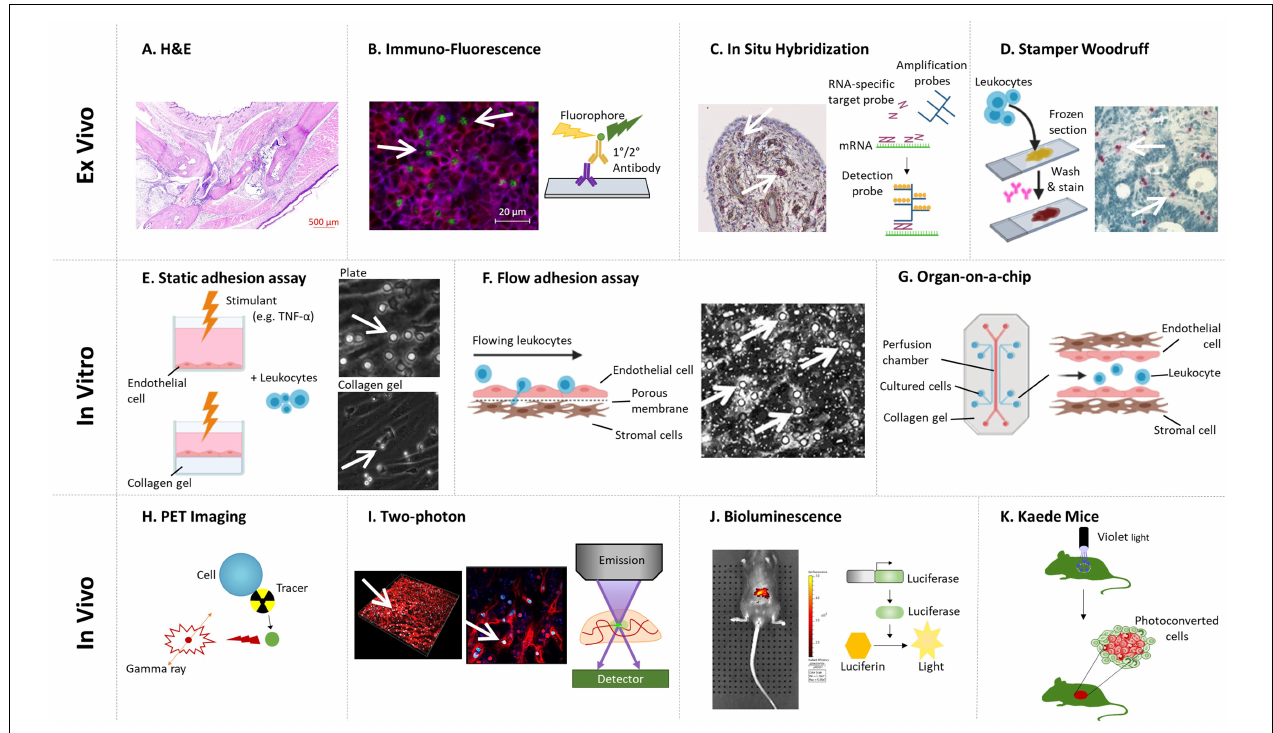
FIGURE 2 | Methodologies for imaging leukocyte infiltration. (A) H&E staining (Tucker et al., 2016): decalcified joints are paraffin embedded, sectioned, and stained with H&E to identify leukocyte infiltration. (B) Immuno-fluorescence (Honvo-Houéto and Truchet, 2015; JoVE, 2021): tissue sections are stained with fluorescently tagged antibodies against specific proteins to visualize cellular localization using a fluorescent microscope. Representative image shows a lymph node stained for CD3 + (Red), CD4 + (Blue), and FoxP3 + (Green) T-cells. In (A,B) , images courtesy of Miss Jenefa Begum (University of Birmingham). (C) In Situ Hybridization (Menon et al., 2017): an RNA-specific target probe is added to tissue sections, where it hybridizes to its corresponding gene. Amplification probes are added to enhance the detection, which are bound by detection probes. Detection probes can either be fluorescent-, antibody- or radio- labeled. Image of arthritic joint replacement tissue section stained for PDGFR β (Red), nuclei (Pale Blue), and CD90 (Brown), courtesy of Dr. Triin Major (University of Birmingham). (D) Stamper–Woodruff assay (Hirata et al., 2004): leukocytes are added to frozen tissue sections on slides and rotated for 30 min. Non-adherent cells are washed off and the section stained with